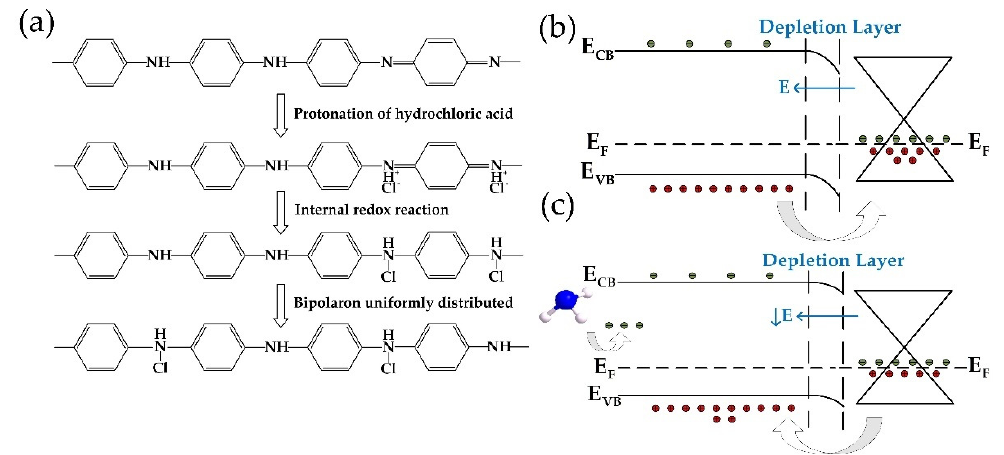
Figure 7. ( a ) Process of hydrochloric acid doping intrinsic PANI. ( b ) Schematic of the junction between PA-PANI and rGO. ( c ) Schematic of charge transport through the junction between PA-PANI and rGO when NH 3 is adsorbed.